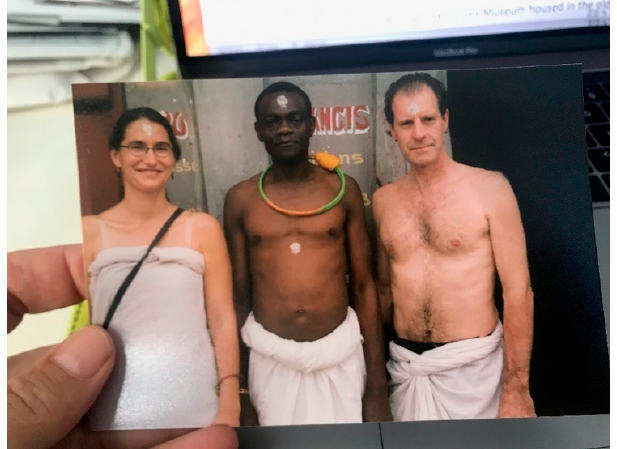
Figure 20. Helen Regis, Basile Adoko, and Peter Sutherland dressed to enter the Vodun shrine in Cottonou. Photograph courtesy of Helen Regis.